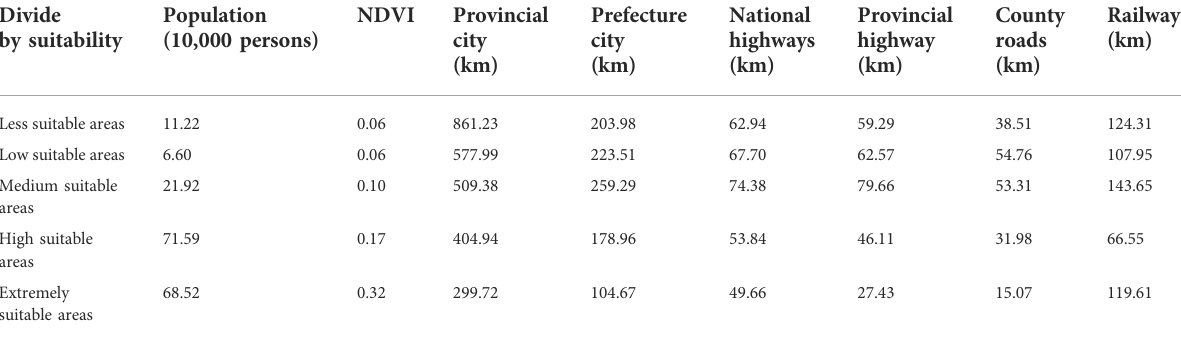
TABLE 6 Statistical summary of the application of deep learning to identify areas in Northwest China with high potential for development as scenic spots. Divide by